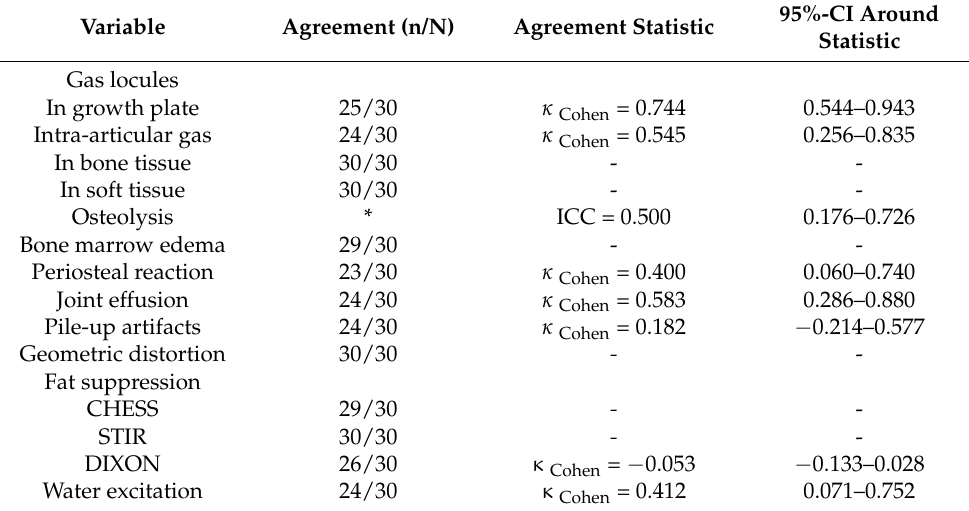
Table 3. Inter-reader agreement on the different